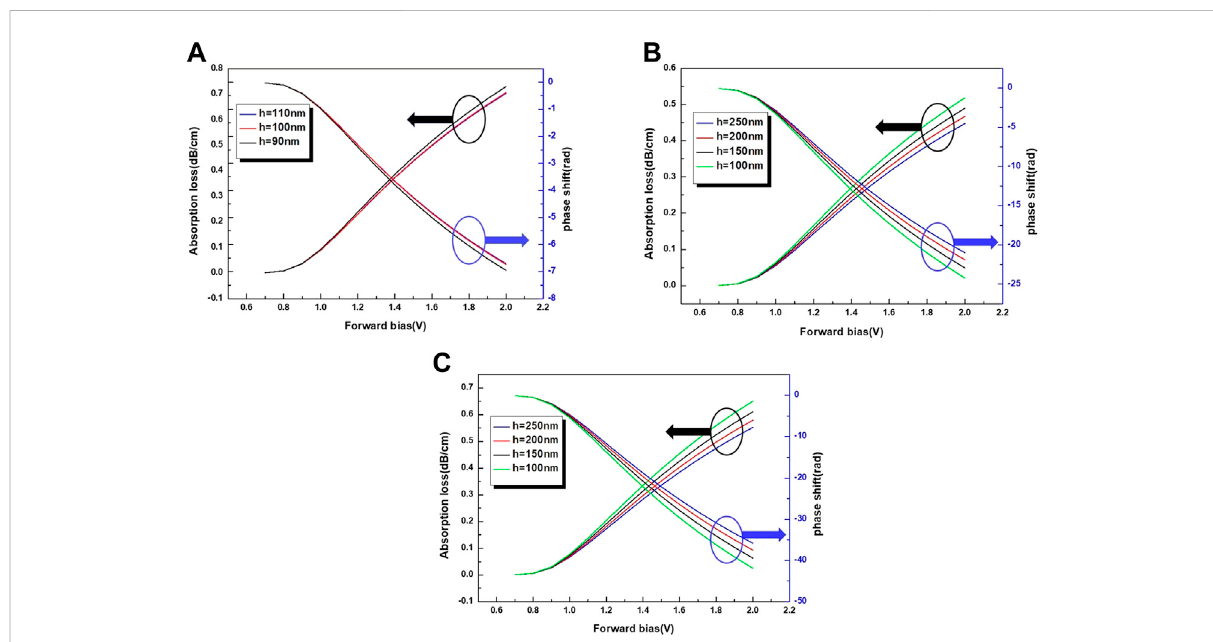
FIGURE 9 Biasvoltagevs.carrierabsorptionlossandsimulatedphaseshiftinthewaveguideregionat (A) 2 μ mwavelength, (B) 4.3 μ mwavelengthand (C) 5 μ m